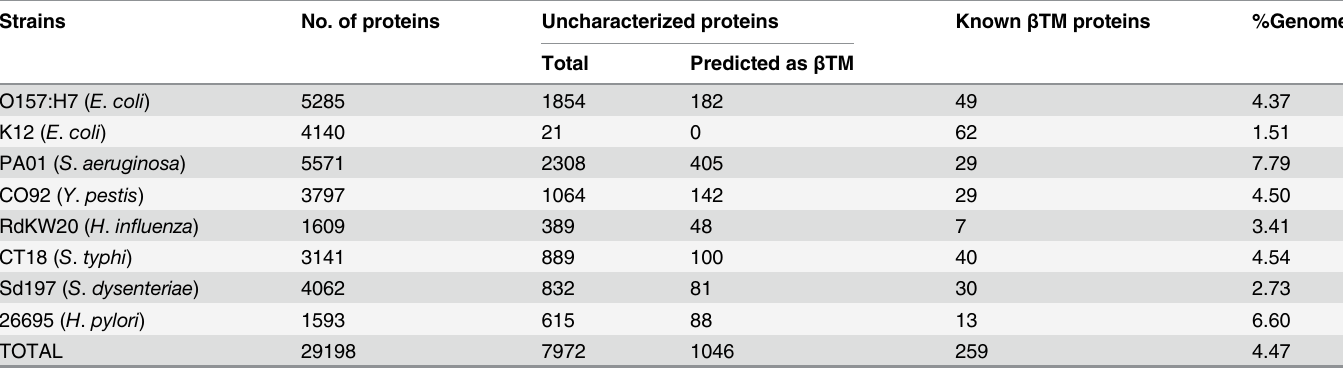
Table 3. Predicted and known β TM proteins in eight bacterial genomes. Strains No. of